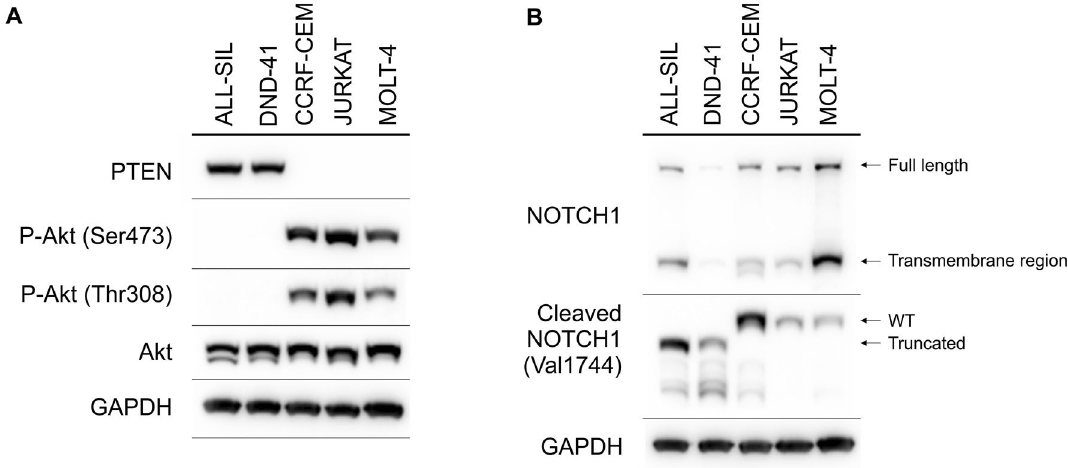
Figure 2. Signaling pathways in T-ALL cell lines. The immunoblot analysis of ( A ) PTEN, P-Akt (Ser473) and P-Akt (Thr308) and ( B ) NOTCH1 and cleaved NOTCH1 in T-ALL cell lines. GAPDH is shown as a loading control. Each immunoblot is a representative result of three independent experiments. Different gels are separated by